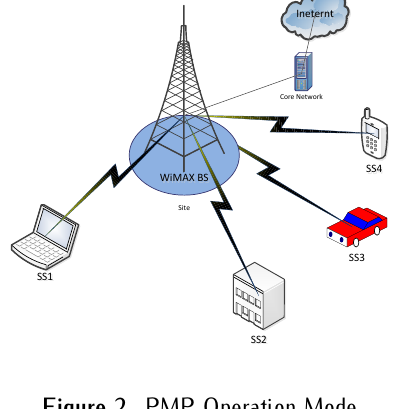
Figure 2. PMP Operation